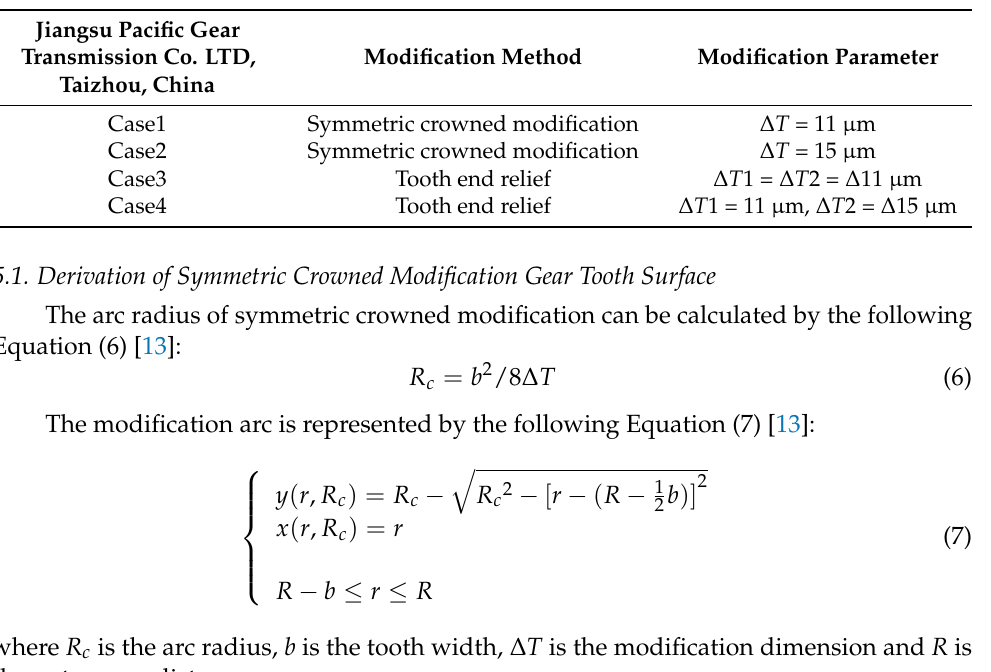
Table 2. Modification method and